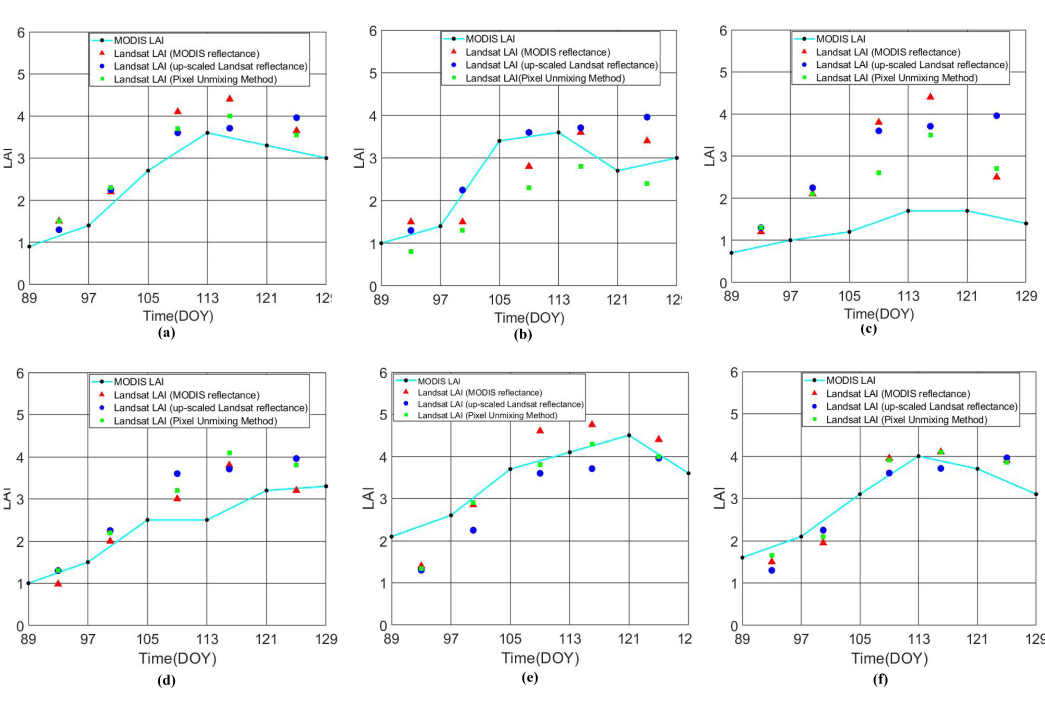
Figure 9. LAI inversion in time series at the Baoding area (MODIS DOY: 89–129), based on the homogeneous and pure pixel filter method and the pixel unmixing method. ( a ) pixel one; ( b ) pixel two; ( c ) pixel three; ( d ) pixel four; ( e ) pixel five and ( f ) pixel